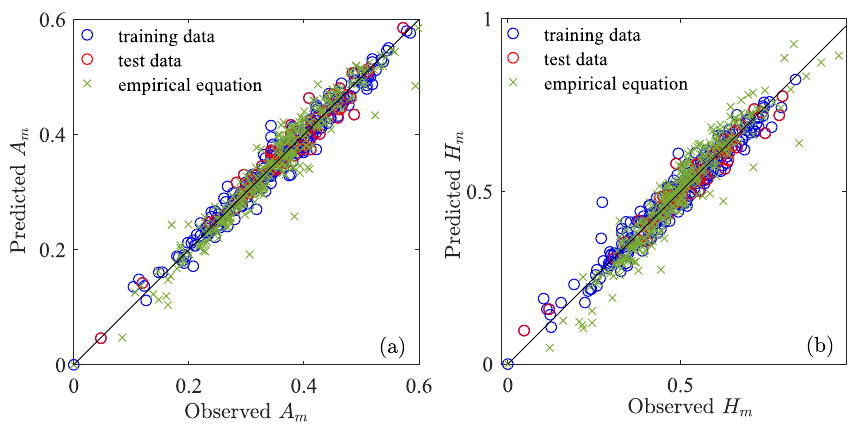
Figure 7. Q-Q plot of observed and predicted ( a ) A m and ( b ) H m , for the empirical equations and the ANN model. Training data and test data in the ANN model are displayed separately.